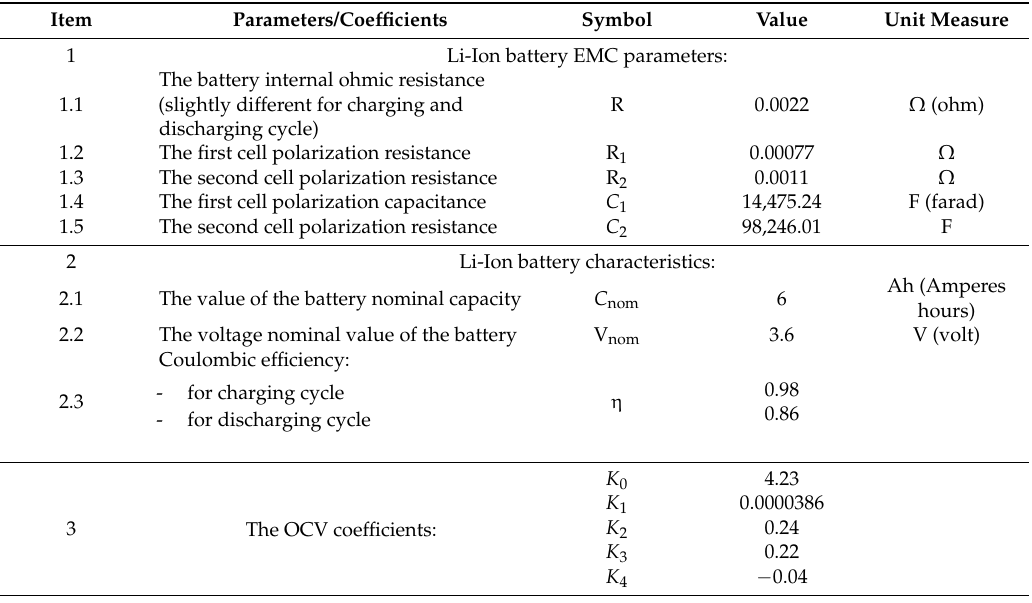
Table 1. The parameters and the coefficients of Li-Ion battery equivalent combined model.